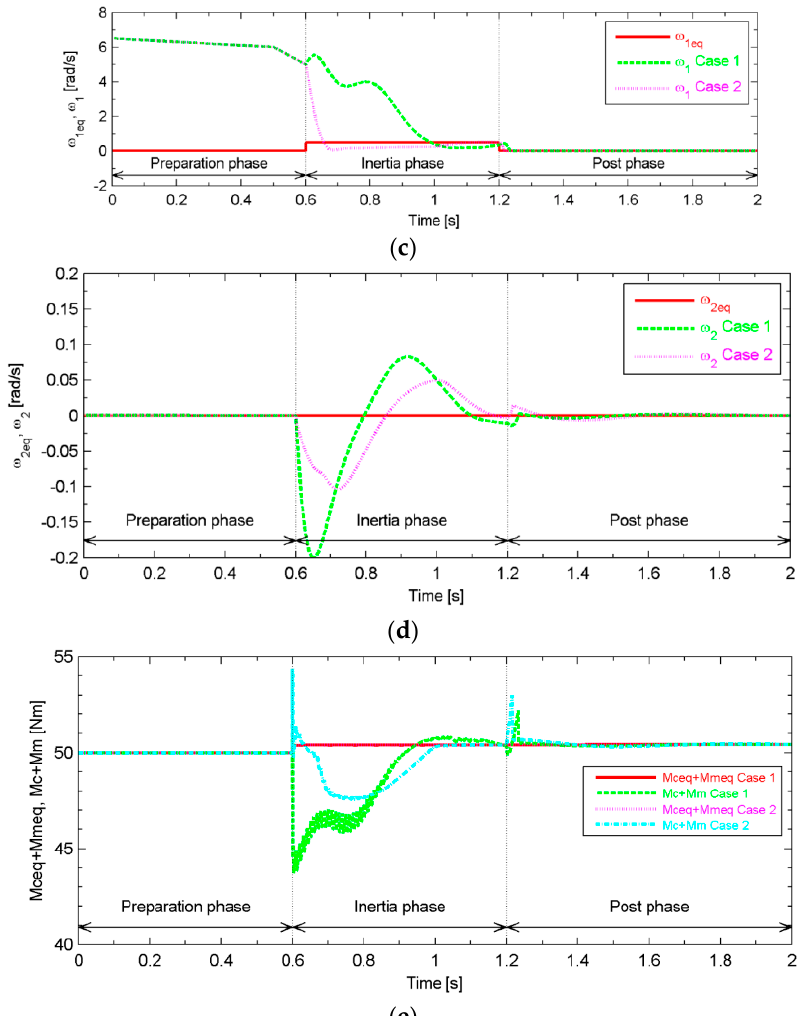
Figure 15. Performance in the case of parameter uncertainty. Case 1: τ c = 0.05 s. Case 2: τ m = 0.005 s. Engine output torque command M ec steps from 0 Nm to 60 Nm at the beginning of the inertia phase. ( a ) Clutch torque command M cc and motor output torque command M mc ; ( b ) Conditions of the constraints; ( c ) Equilibrium state of the clutch sliding speed ω 1 eq and clutch sliding speed ω 1 ; ( d ) Equilibrium state of the time derivative of torsion of the axle shaft ω 2 eq and time derivative of torsion of the axle shaft ω 2 ; ( e ) Torque demanded by the driver M ceq + M meq and torque supplied by the hybrid power source M c + M m